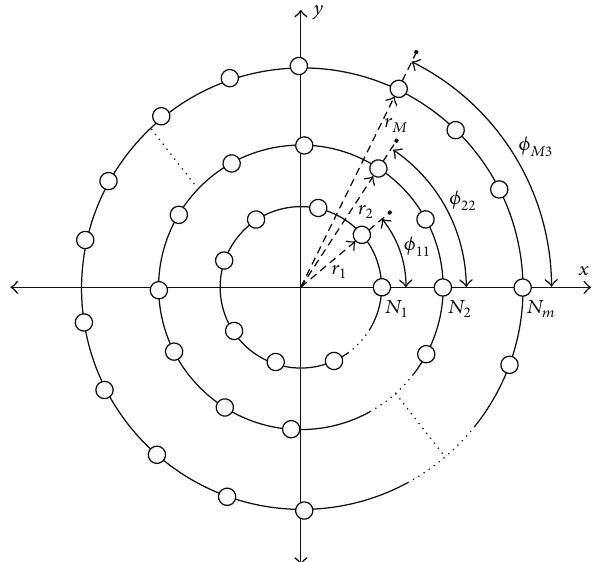
Figure 1: Geometry of a concentric circular array. Table 1: MSL, FNBW, and DRR values obtained by BSA and other optimization techniques EP [1], PSO [1], PSOCFIWA [1], CPSO [2],